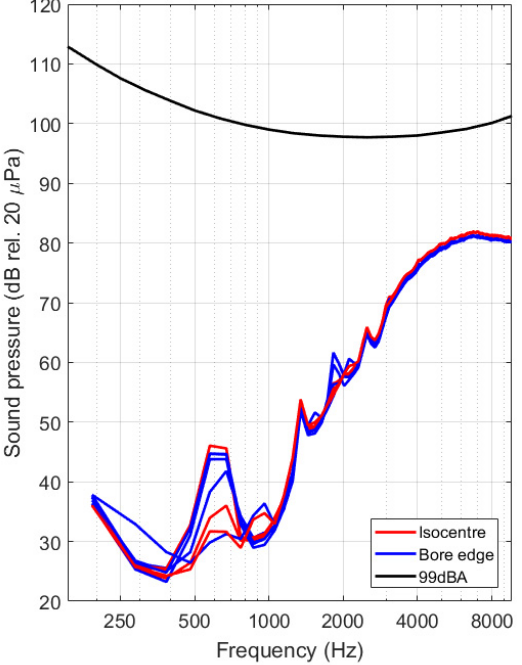
Figure 20. Spectra of estimated sound pressure levels for the datasets acquired during the second experimental campaign. Datasets are grouped per test location, showing signals when the actuator was located in the scanner isocenter (red solid line), at the end of the bore on the patient bed (green) and right next to the scanner bore opening (blue). The minimal acceptable noise floor of 99 dBA [21] is visualized using a black solid